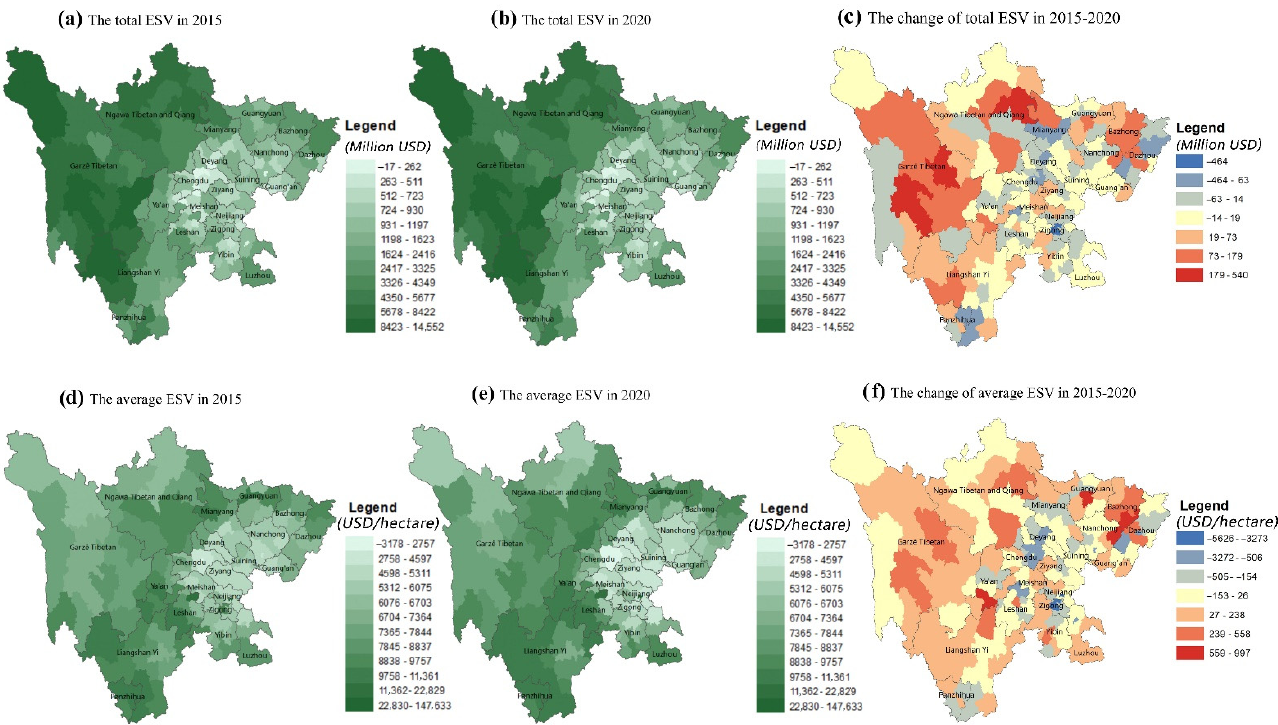
Figure 9. The changes in total ESVs in 183 county-level cities during 2015–2020.